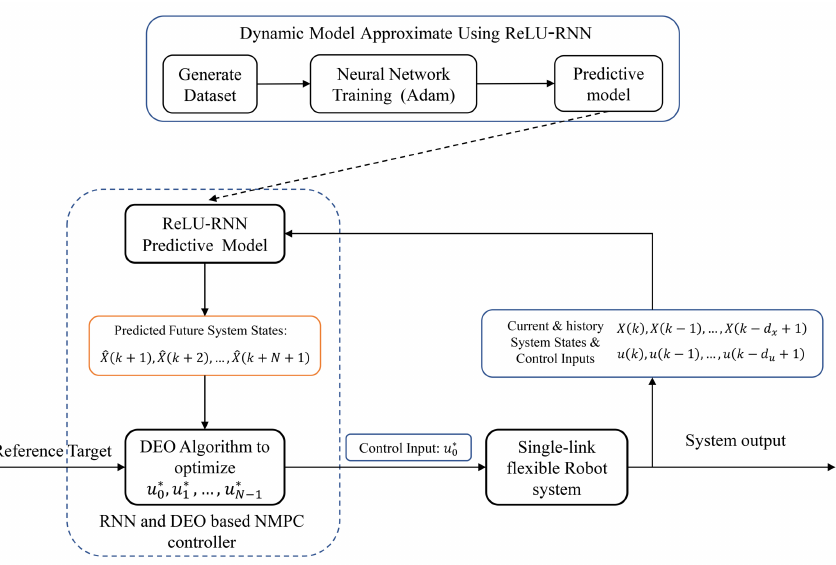
Figure 4. The architecture of RNN and DEO based NMPC